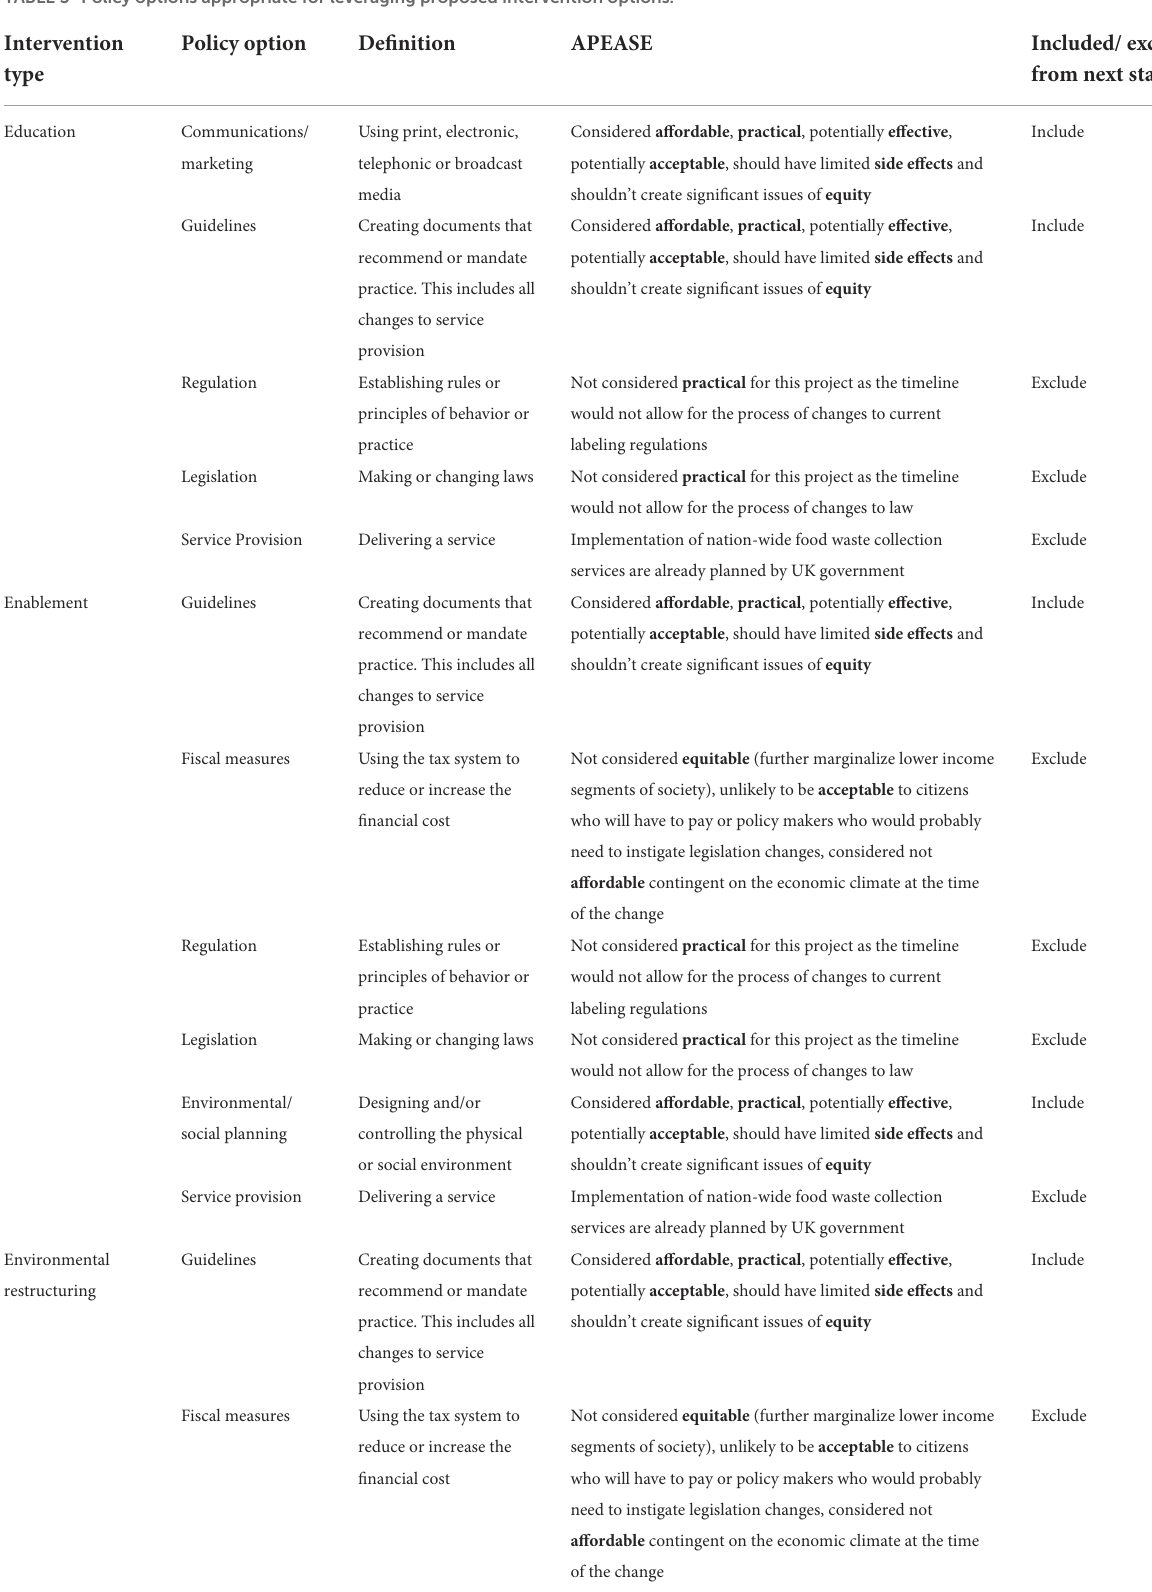
TABLE 3 Policy options appropriate for leveraging proposed intervention